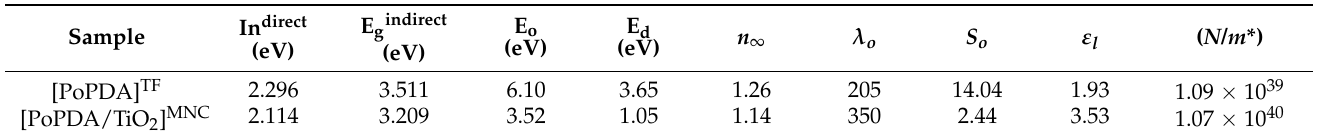
Table 3. The optical parameters for the application of Wemple–DiDomenico and Sellmeier models on [PoPDA] TF and [PoPDA/TiO 2 ] MNC .